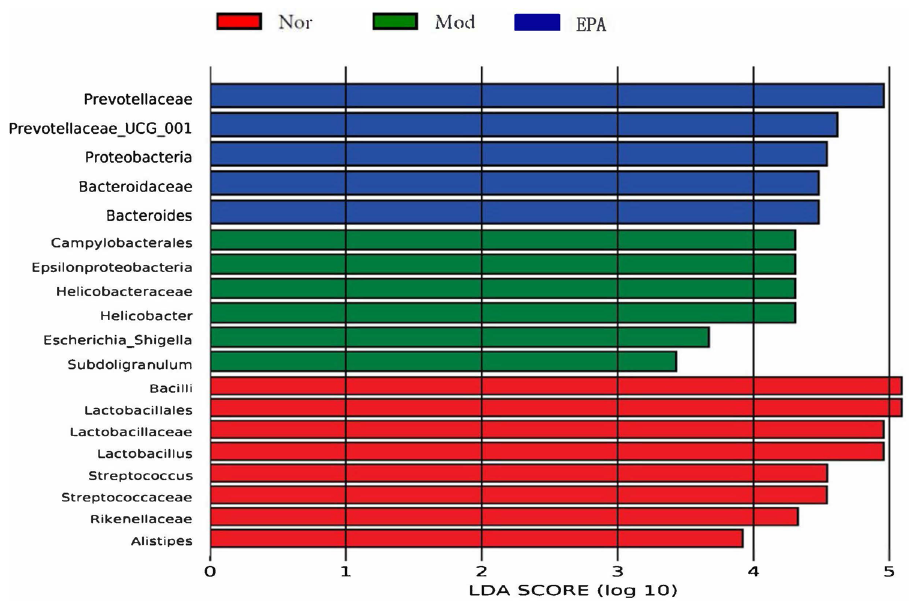
Figure 13. The LDA score obtained from LEfSe analysis of gut microbiota in different groups.